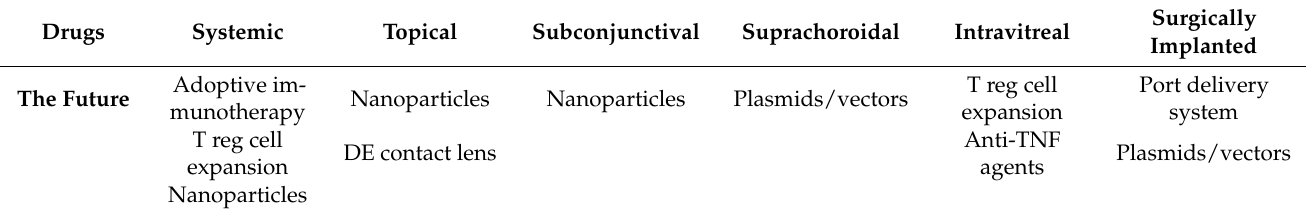
Table 4. Therapies on the horizon. DE, drug-eluting; TNF, tissue necrosis factor; T reg, T regulatory cells. Drugs Systemic Topical Subconjunctival The